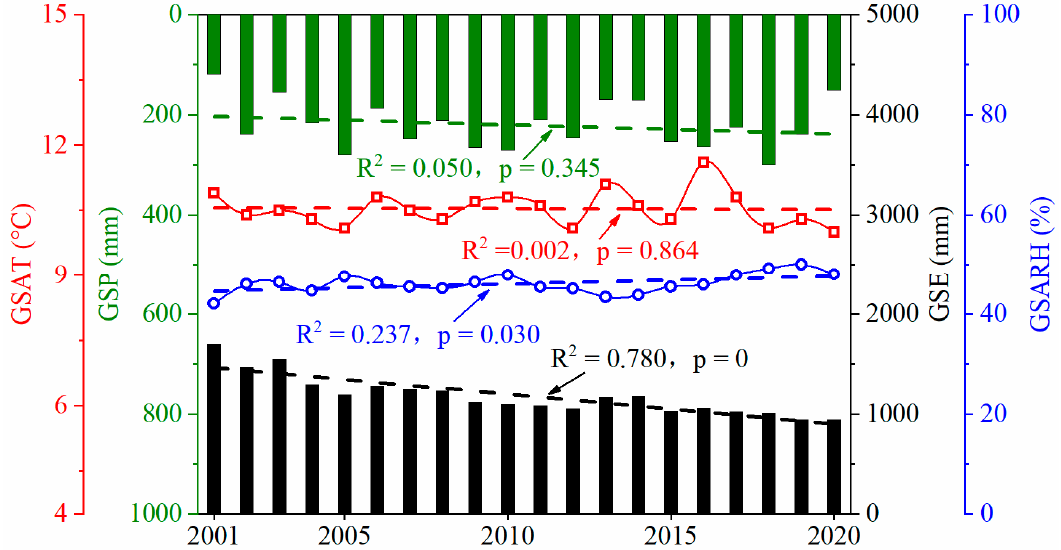
Figure 8. Interannual variation of growing season climate factors from 2001 to 2020. GSAT, GSP, GSE, GSARH represent Growing Season Average Temperature, Growing Season Precipitation, Growing Season Evaporation, and Growing Season Average Relative Humidity, respectively.